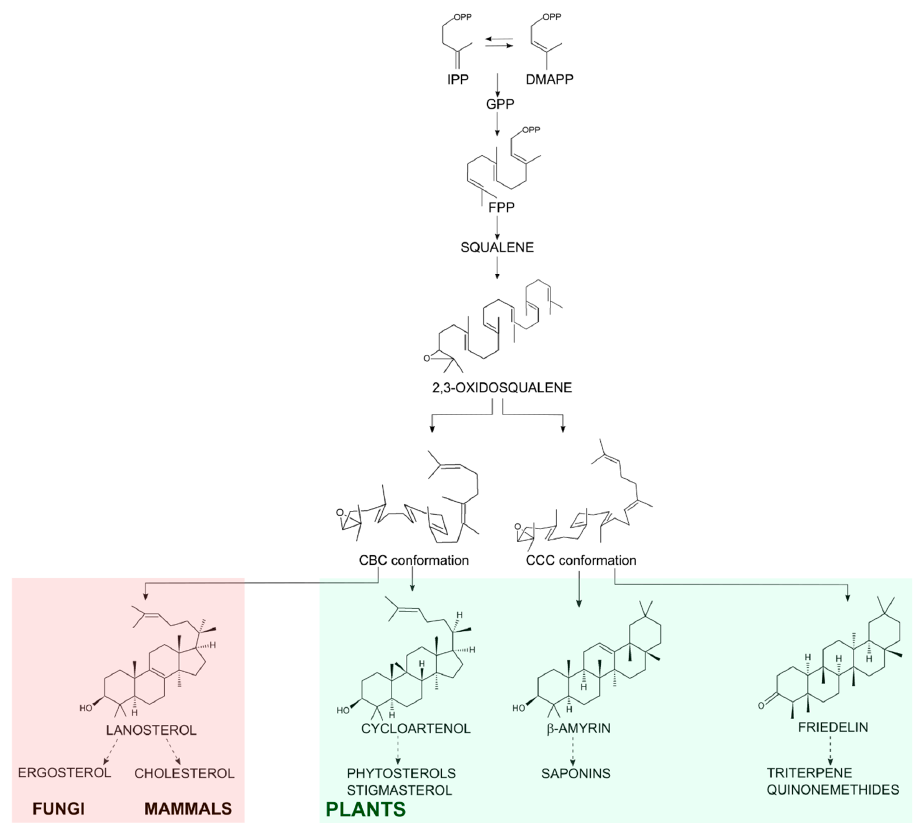
Figure 1. Schematic biosynthesis of steroidal and pentacyclic triterpene. Conjugation of isopentenyl pyrophosphate (IPP) with its isomer dimethylallyl pyrophosphate (DMAPP) generates the 10-carbon molecule geranyl pyrophosphate (GPP). GPP conjugation to another IPP monomer generates the C-15 farnesyl pyrophosphate (FPP). Then, the conjugation of 2 FPP molecules generates the C-30 precursor squalene. After oxidation of squalene, 2,3-oxidosqualene is cyclized by the OSCs in the organism. In fungi, mammals and plants the chair-boat-chair (CBC) conformation results in the steroidal lanosterol (in the light red shadow) or cycloartenol (in the light green shadow). In plants, the OSCs enable a chair-chair-chair (CCC) conformation resulting in triterpenes as β -amyrin and friedelin (in the light green shadow).